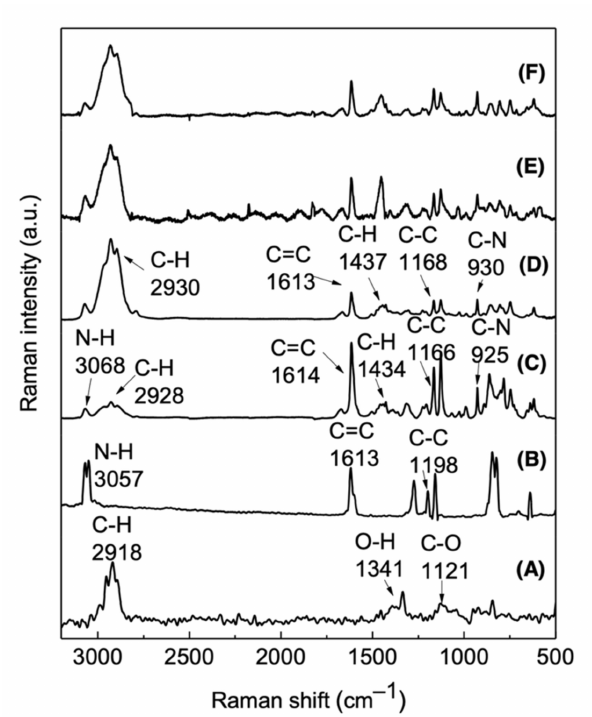
Figure 2. Raman spectra of ( A ) α -CD, ( B ) ODA, ( C ) ODA-PHA, ( D ) α -CD/ODA-PHA, ( E ) β - CD/ODA-PHA, and ( F ) γ